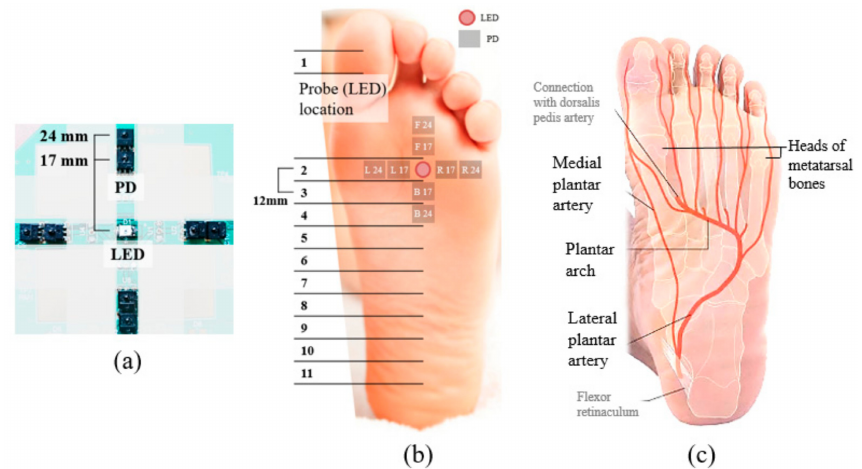
Figure 1. Foot PPG with direct skin contact based on the anatomical structure. ( a ) Probe for foot PPG. ( b ) Probe locations and PD placement. ( c ) Anatomical structure of the sole of the